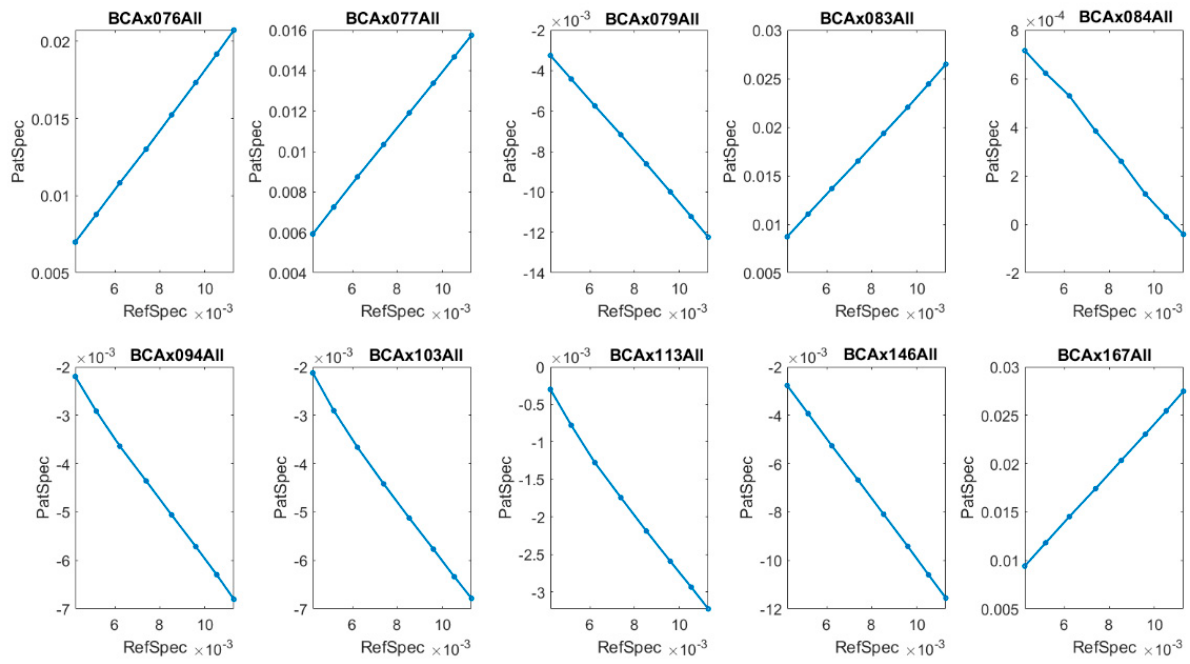
Figure 5. Lissajous curve for (RefSpec(k), PatSpec(k)), k ∈ (1042,1050) [cm − 1 ]) for ten BCP-ALL patients. The phase shift between IR spectra of patients: BCAx076ALL, BCAx077ALL, BCAx083ALL, BCAx167ALL, and reference IR spectra RefSpec is equal to zero, whereas for the remaining patients it is equal to π .